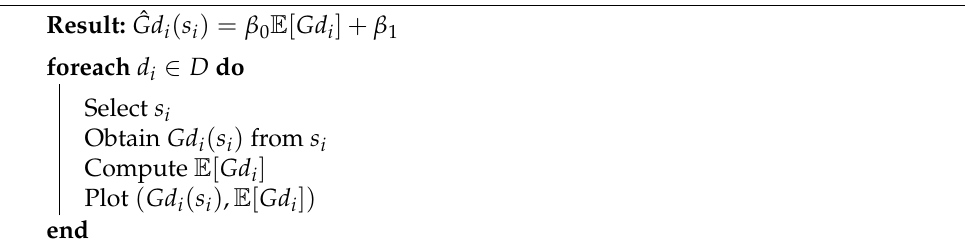
Algorithm 1: Correlation Between Mean Discussion Grade and Student Grade.